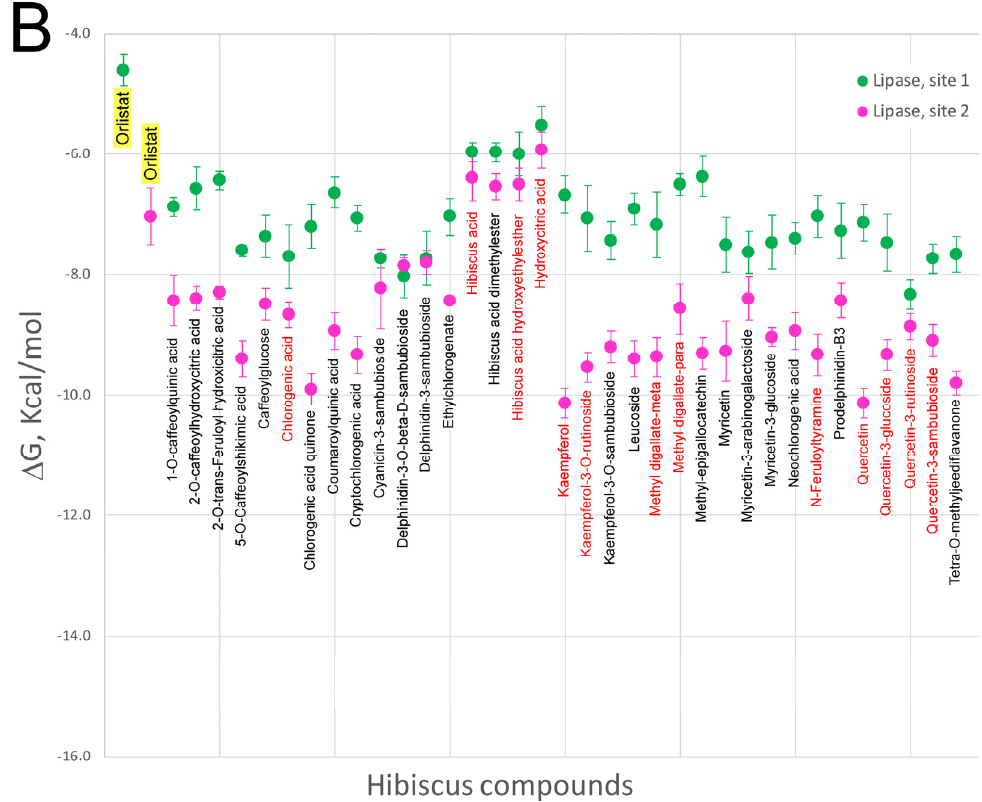
Figure 2. Comparison of the free energy variation ( ∆ G, kcal/mol) of the Hibiscus sabdariffa bioactive compounds and X-ray co-crystalized ligands or known modulators (first name of each panel and yellow background) against the main binding sites of the catalytic binding site of some glucosidase enzymes (panel A) and the two crystal binding sites of the triacylglycerol lipase/colipase complex (panel B) by molecular docking. The common name of each compound is included under mean and standard deviation plotted in each panel. Red colour names indicate that these compounds have been identified as plasma metabolites in the bibliography. For the virtual screening process, a chemical library containing the chemical structures to be screened was initially built, following ADMET criteria.